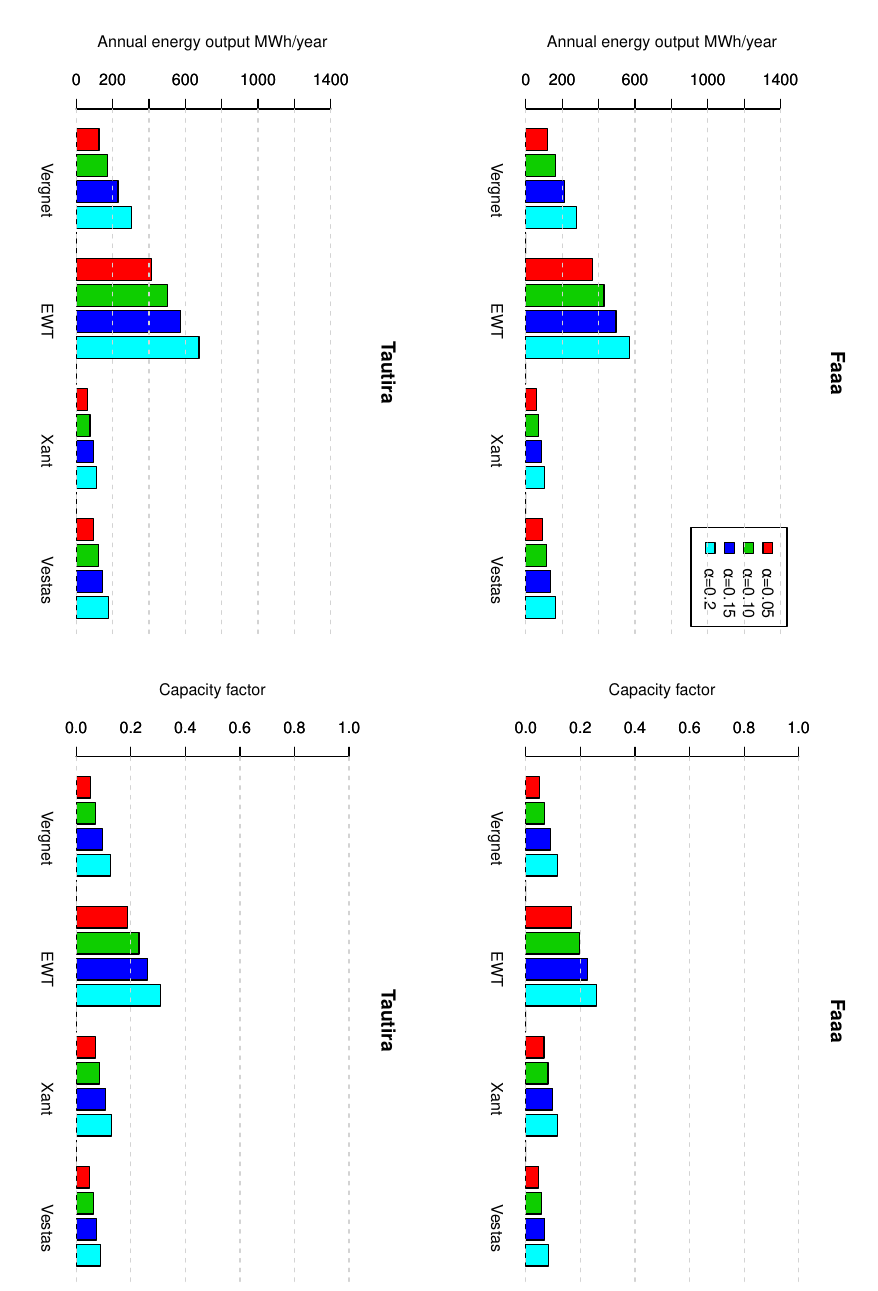
Figure 7. Annual energy output and capacity factor for 4 turbines and 4 PLI values in Faaa and